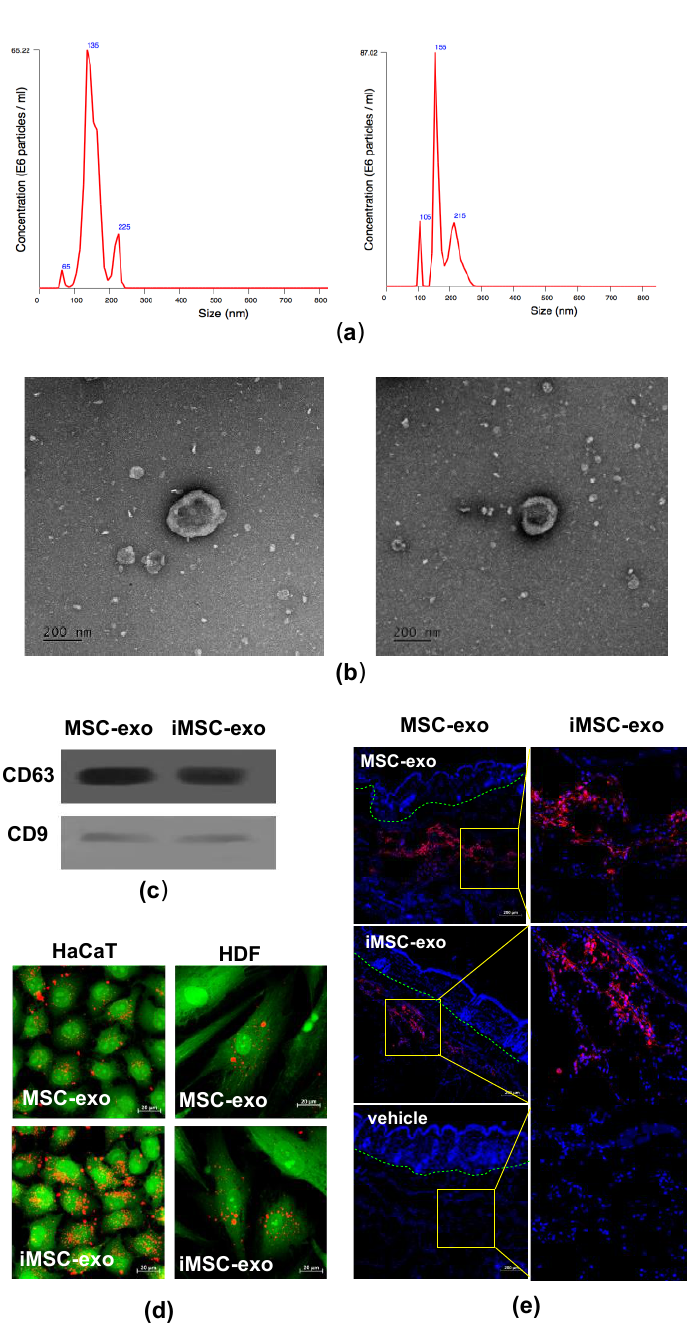
Figure 2. Characterization of exosomes derived from MSCs and iMSCs. ( a ) Nanoparticle analysis of MSC-exo and iMSC-exo. The mean diameter was 167 and 147 nm for MSC-exo and iMSC-exo, respectively. ( b ) TEM analysis of exosomes. Scale bars are 200 nm. ( c ) Immunoblotting for CD63 and CD9 in exosomes. ( d ) Verification of the uptake of exosomes in skin cells. MSC-exo or iMSC-exo (20 µg/mL) were stained with PKH26 ® (red) and incubated with HaCaT and HDFs for 24 h. Before analysis, cells were counterstained with CellTracker ® (green). Scale bars are 20 µm. ( e ) Confocal images of mouse skin tissues treated with MSC-exo or iMSC-exo. A total of 30 µg of PKH26-labeled (red) exosomes were injected into the dorsal skin and tissues were collected after 24 h. Saline (vehicle) was used as negative control. Nuclei were stained with DAPI (blue) for counterstaining. Green dotted lines delineate epidermal-dermal junction. Scale bars are 200 µm.